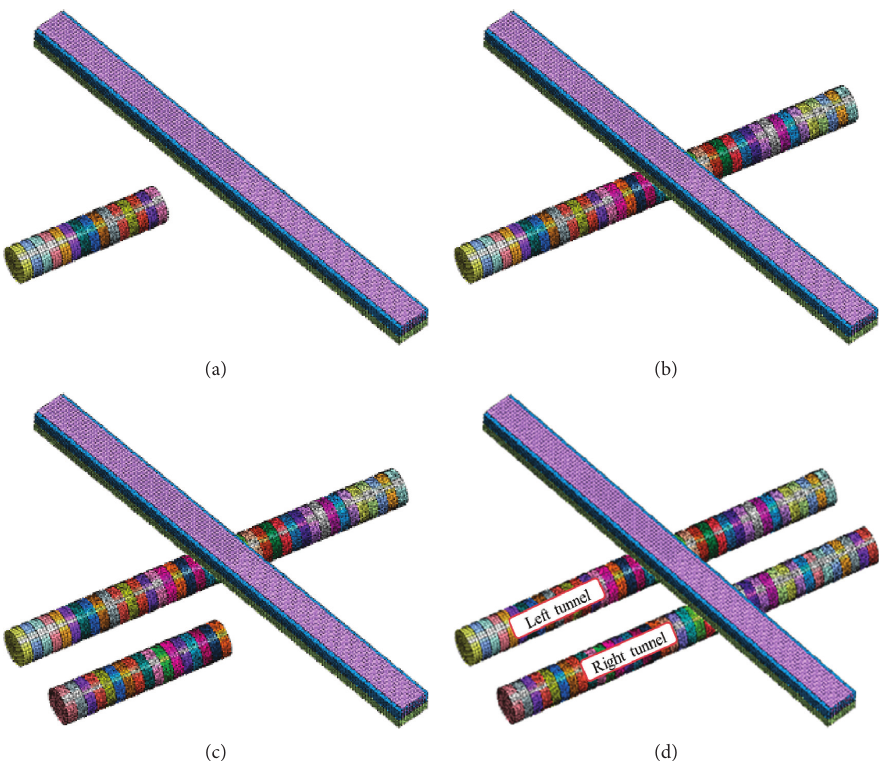
Figure 6: Construction order diagram. (a) Left tunnel construction. (b) The left tunnel cuts through the existing line. (c) Right tunnel construction (d) The right tunnel cuts through the existing line.